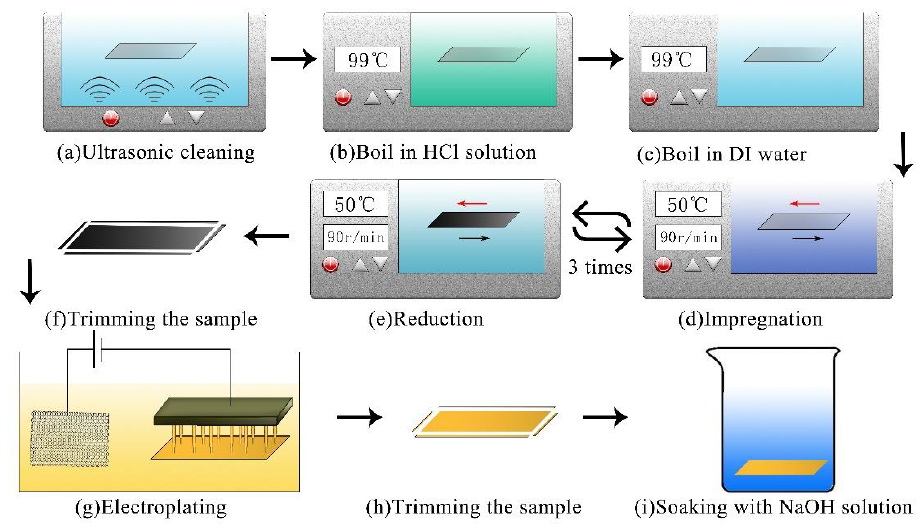
Figure 2. The detailed fabrication process of IPMC.